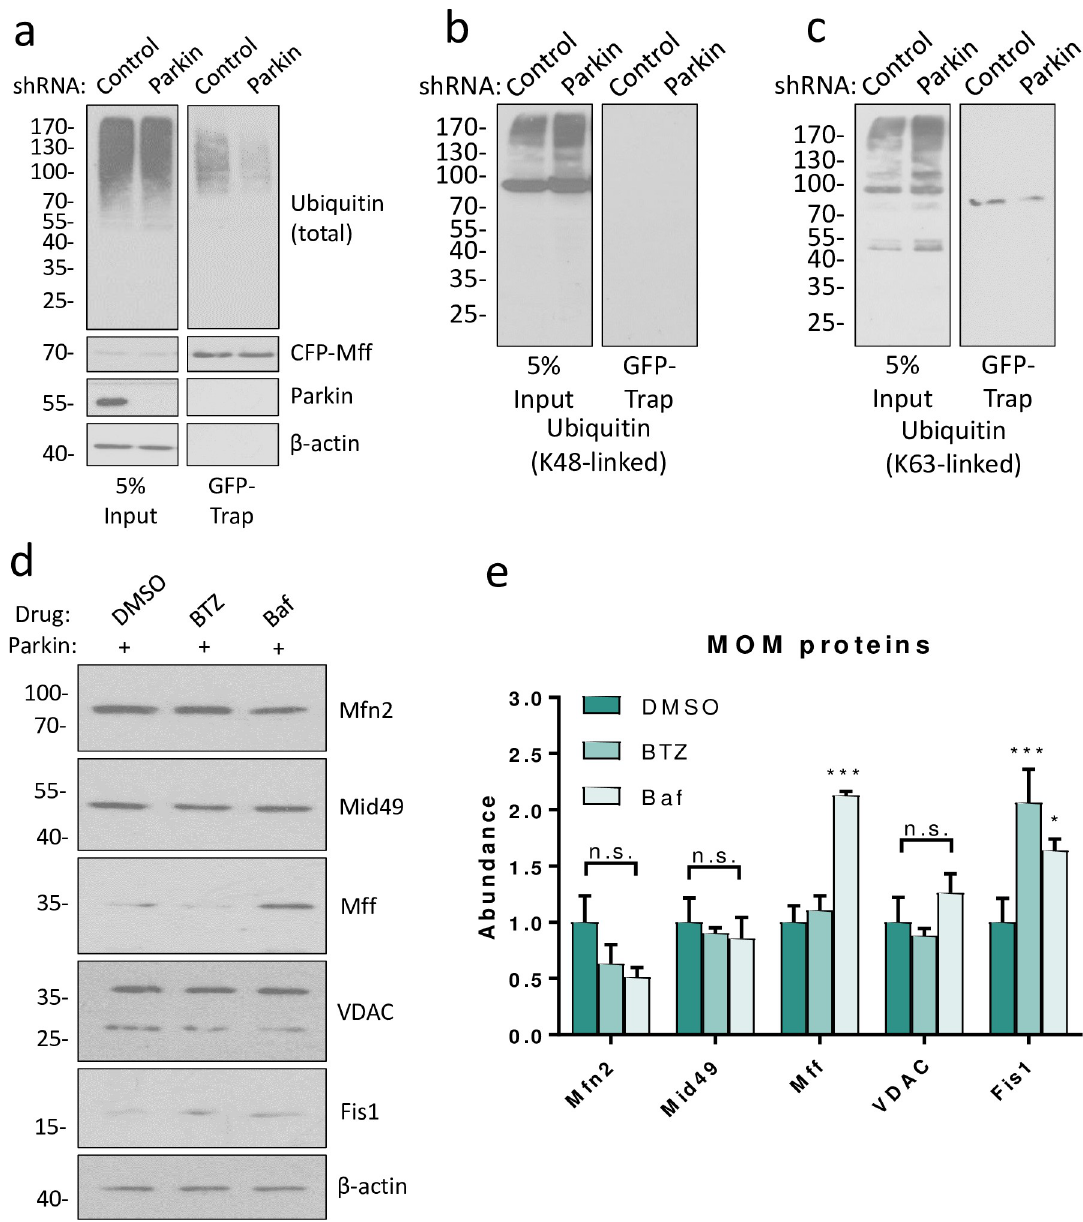
Fig 4. Parkin mediated degradation of Mff is lysosome-dependent. a) HEK293T cells were co-transfected with CFP-Mff or GFP and shRNA (scrambled control or Parkin-targeting). Western blots of GFP-immunoprecipitation. As in Fig 2, knockdown of Parkin reduces total Mff ubiquitination. b) Samples from (a), showing no co-immunoprecipitation of K48-linked ubiquitin with CFP-Mff. c) Samples from (a), showing co-immunoprecipitation of a single K63-linked ubiquitinated CFP-Mff species. d) HEK293T cells were transfected with untagged Parkin. Prior to lysis 48 hours post- transfection, cells were treated with DMSO (control), bortezomib (BTZ, proteasomal inhibitor, 1 μ M) or bafilomycin (Baf, lysosomal inhibitor, 100nM) for 6 hours. Lysates were then Western blotted for Mff and other mitochondrial membrane proteins. e) Quantitative analysis of (d), data presented as mean ± SEM. Analysed using ordinary two-way ANOVA with Dunnett’s correction for multiple comparisons. N = 3. � p < 0.05, ��� p < 0.001. (shParkin) or a control shRNA sequence. shParkin reduced Parkin levels to 6% of control lev- els 72 hours after transfection (Fig 1A and 1C). Consistent with Parkin-mediated degradation of Mff there was a corresponding increase in levels of Mff (Fig 1A and 1B). To exclude the